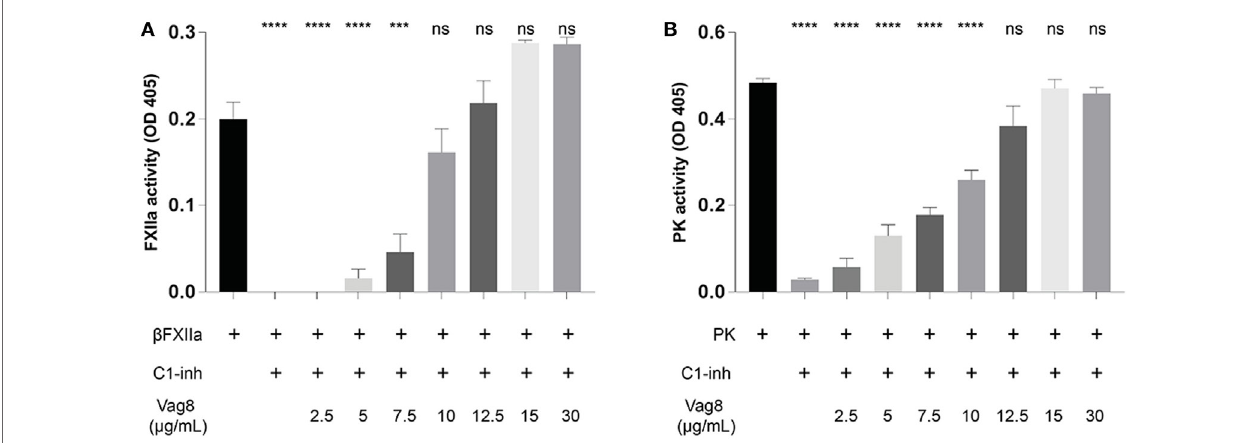
FigUre 2 | Virulence associated gene 8 (Vag8) interferes with the inhibition of β FXIIa and plasma kallikrein (PK) by complement regulator C1 inhibitor (C1-INH). (a) Vag8 (2.5, 5, 7.5, 10, 12.5, 15, and 30 µg/mL) dose-dependently enhances the activity of 1 µg/mL β FXIIa in the presence of 10 µg/mL C1-INH reaching similar activity as β FXIIa alone upon using 10 µg/mL of Vag8. (B) Vag8 (2.5, 5, 7.5, 10, 12.5, 15, and 30 µg/mL) dose-dependently enhances the activity of 0.5 µg/mL PK in the presence of 10 µg/mL C1-INH reaching similar activity as PK alone upon using 12.5 µg/mL of Vag8. Data represent the mean ± SEM of three separate experiments. *** p ≤ 0.001, **** p ≤ 0.0001, ns = non-significant compared to the black